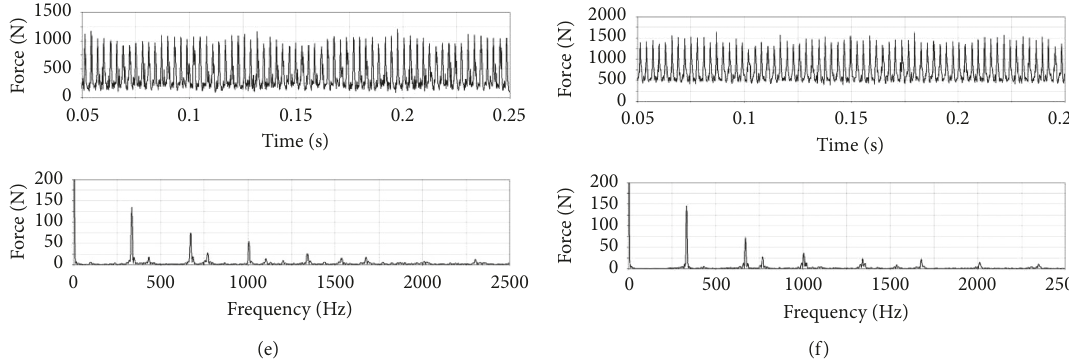
Figure 3: Time histories and frequency spectra of bearing constraining forces. (a) Engine input shaft bearing. (b) MG1 input shaft bearing. (c) Composite mechanism bearing. (d) MG2 input shaft bearing. (e) First reduction gear shaft bearing. (f) Second reduction gear shaft